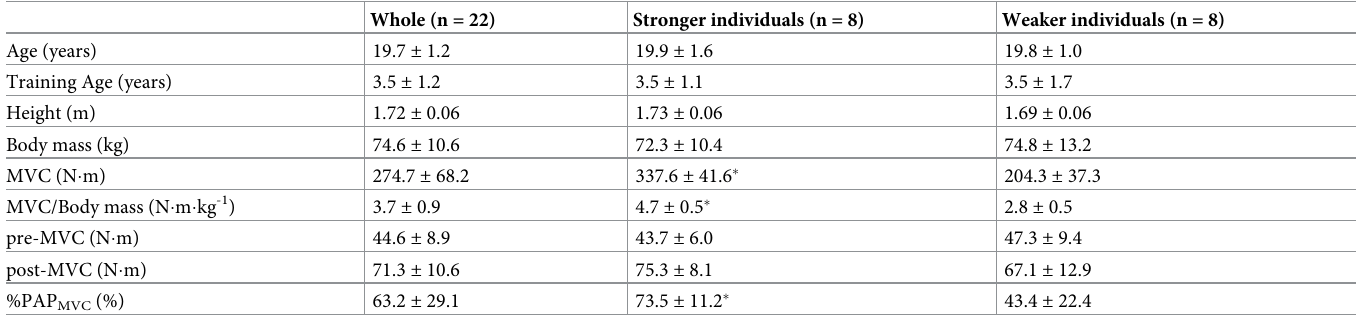
Values are presented as means ± standard deviation. MVC, maximal voluntary contraction; pre-MVC, twitch torque before MVC; post-MVC, twitch torque after MVC. The statistical difference is set at p < 0.05: difference versus weaker individuals �